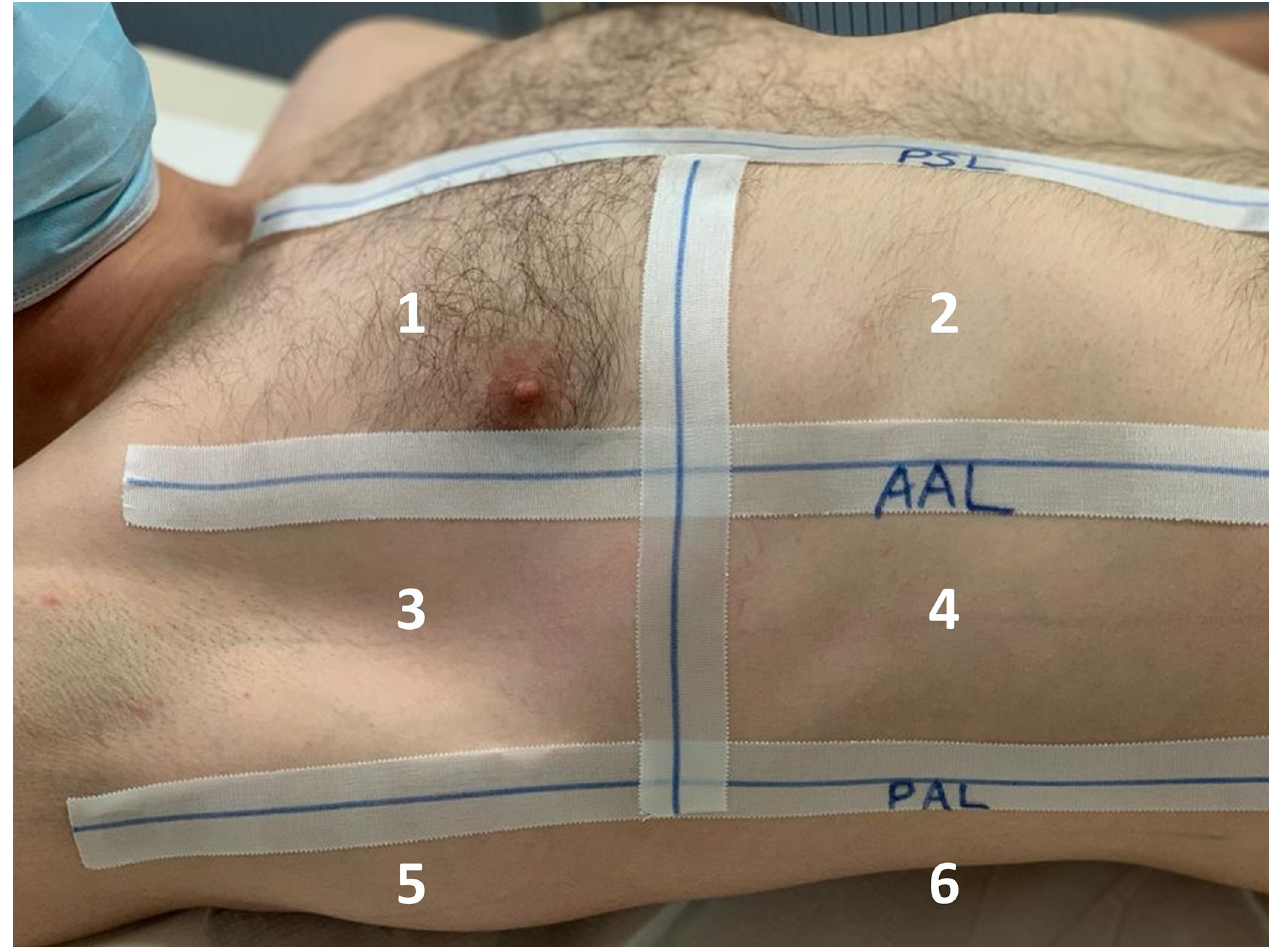
Fig 1. Lung areas for the right lung, PSL = parasternal line, AAL/PAL = anterior/posterior axillary line.